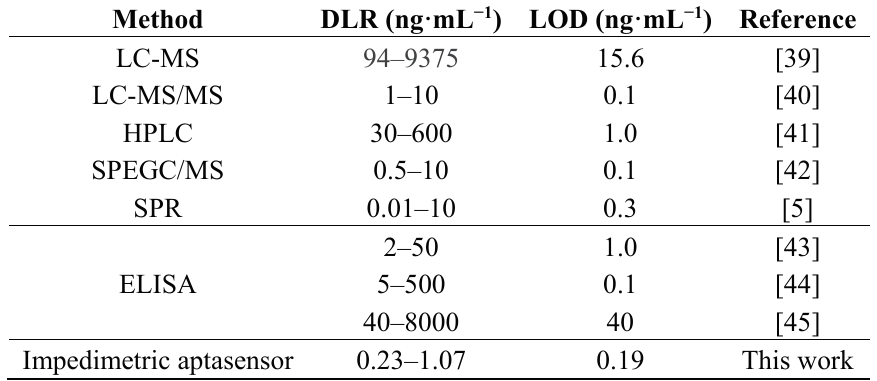
Table 1. The analytical parameters of tetrodotoxin determination